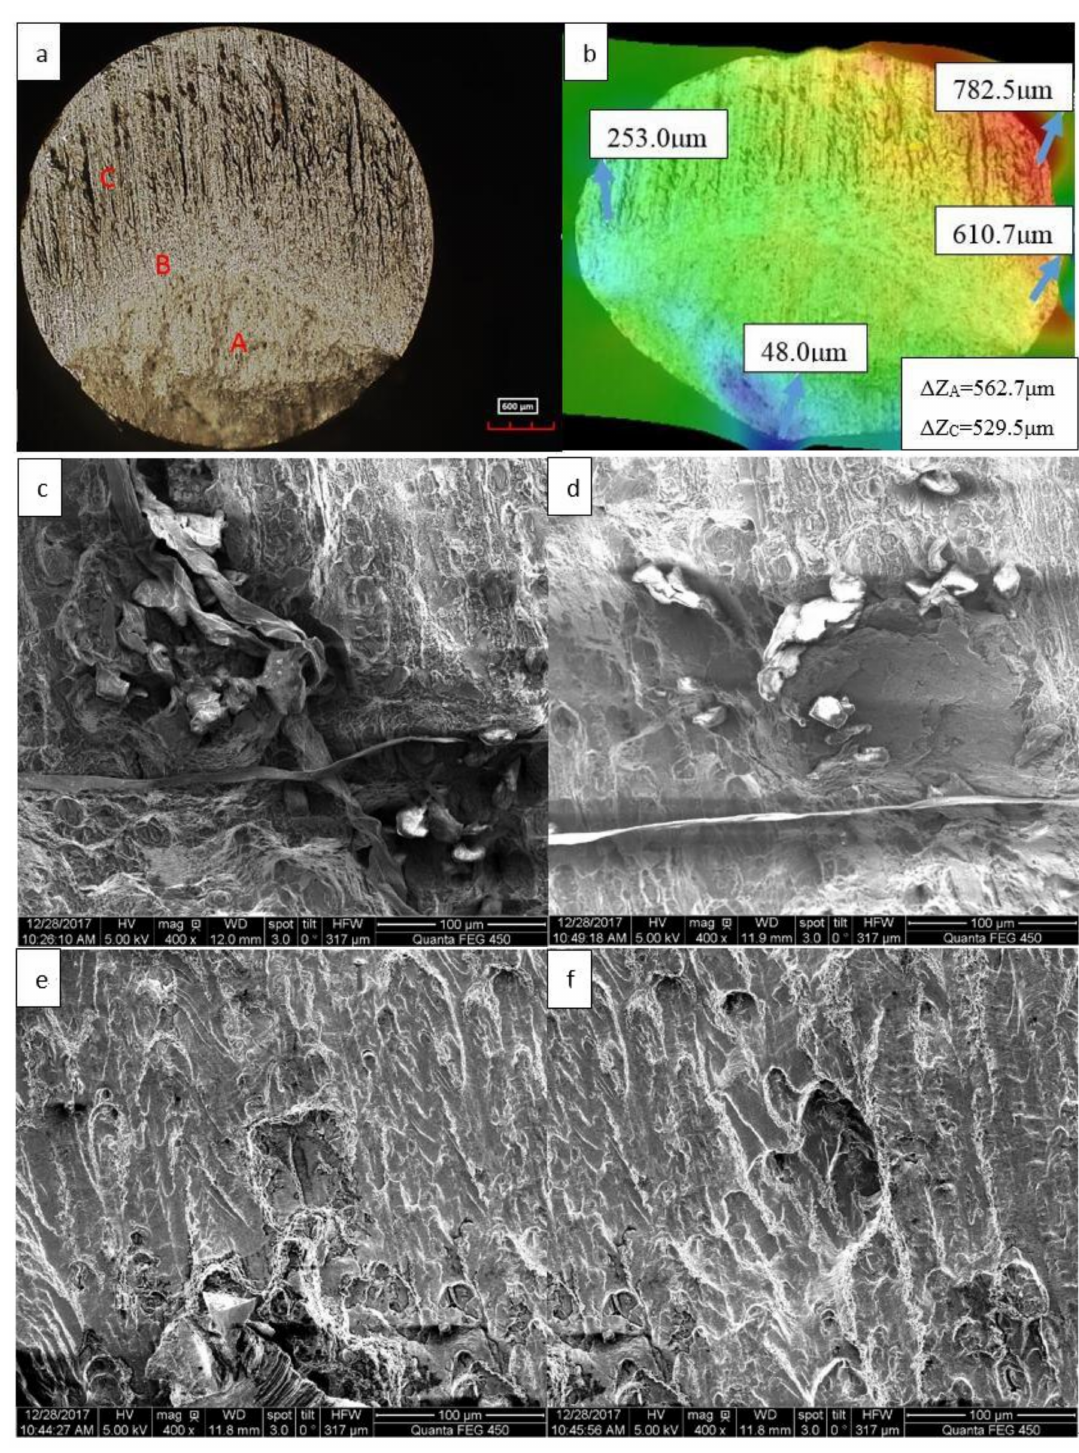
Figure 7. Fatigue fracture surface of N f = 4.210 × 10 5 , σ = 113.3 MPa in air for the uncoated sample. ( a ) Macro-scale view of the fracture surface; ( b ) Three-dimensional view of the fracture surface; ( c , d ) region labeled A; ( e ) region labeled B; ( f ) region labeled